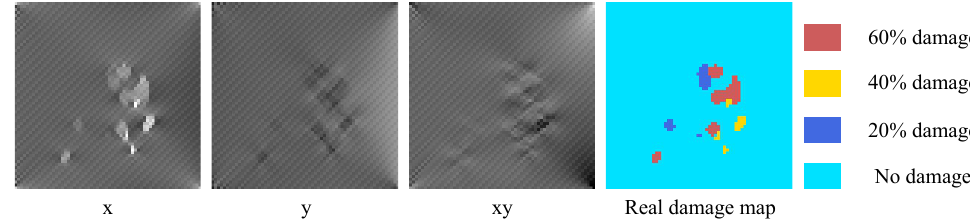
Figure 6. Example of plate dataset.